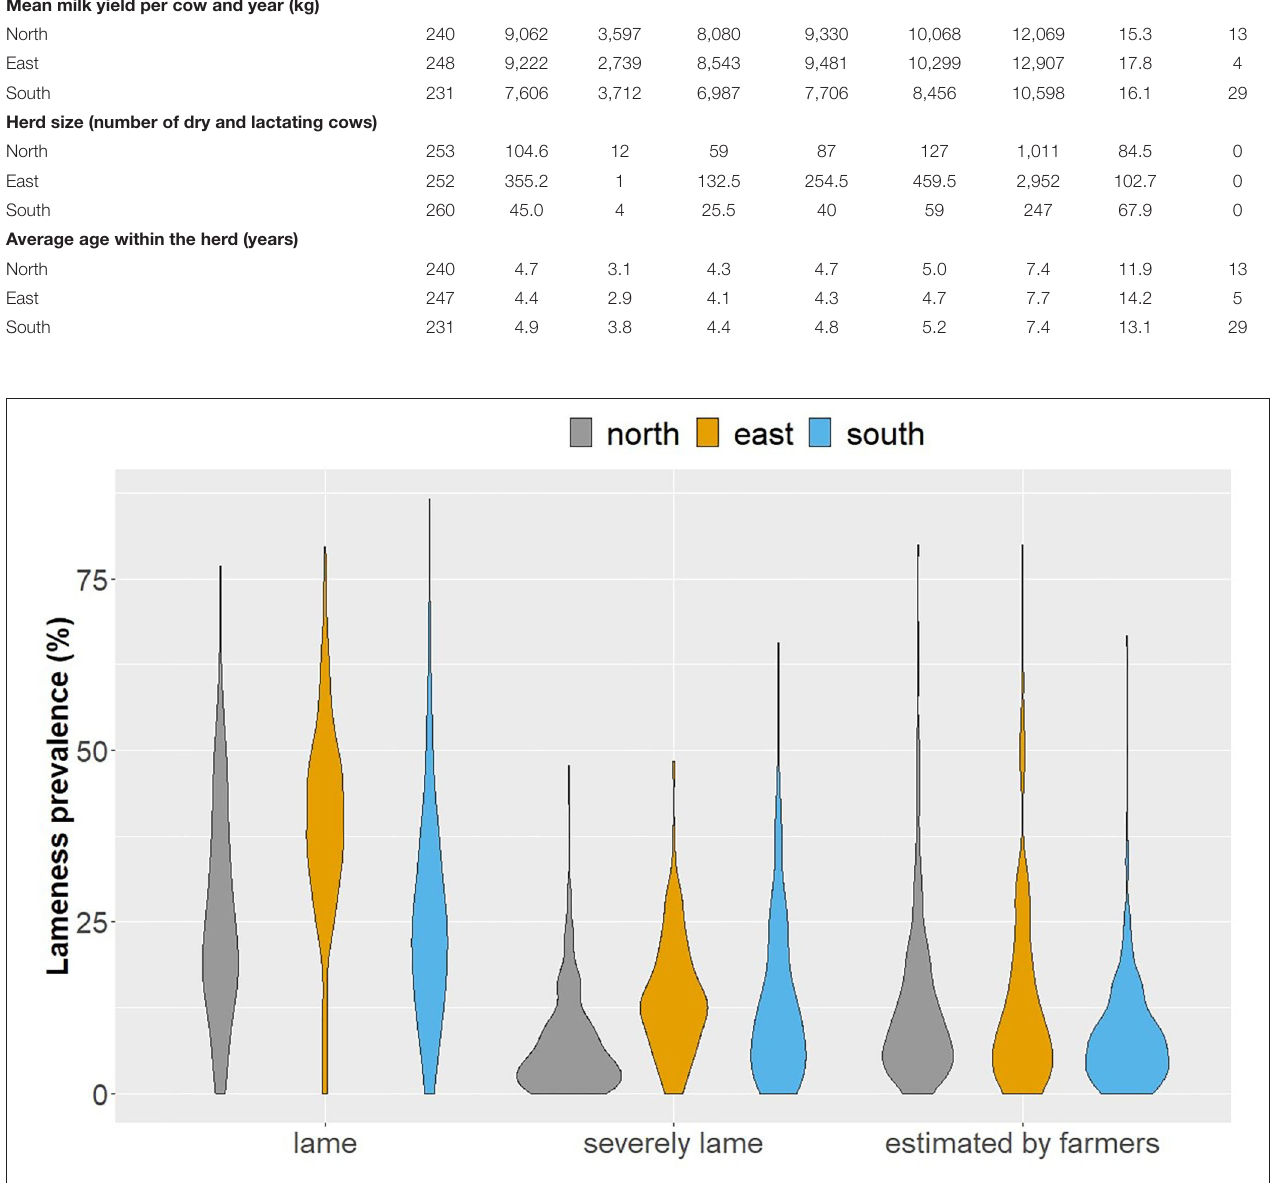
FIGURE 1 | Distribution of lameness prevalence assessed by researchers and estimated by farmers grouped by region. Researchers’ prevalence: n = 251 (north and east), n = 249 (south). Farmers’ prevalence: n = 253 (north), n = 250 (east), n = 259 (south).